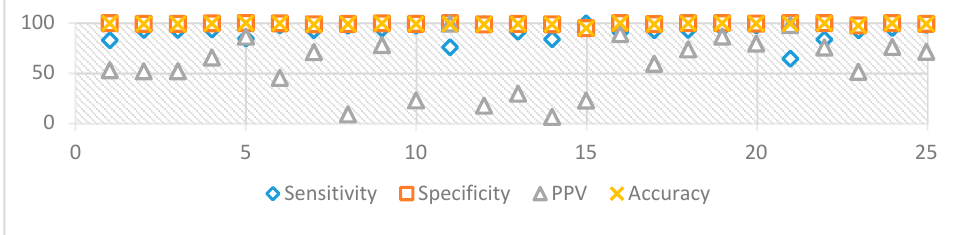
Figure 15. Extracting exudates in DIARETDB0: Image #21 ( a , b ), Image #25 ( c , d ), Image #27 ( e , f ), and Image #16 ( g , h ).